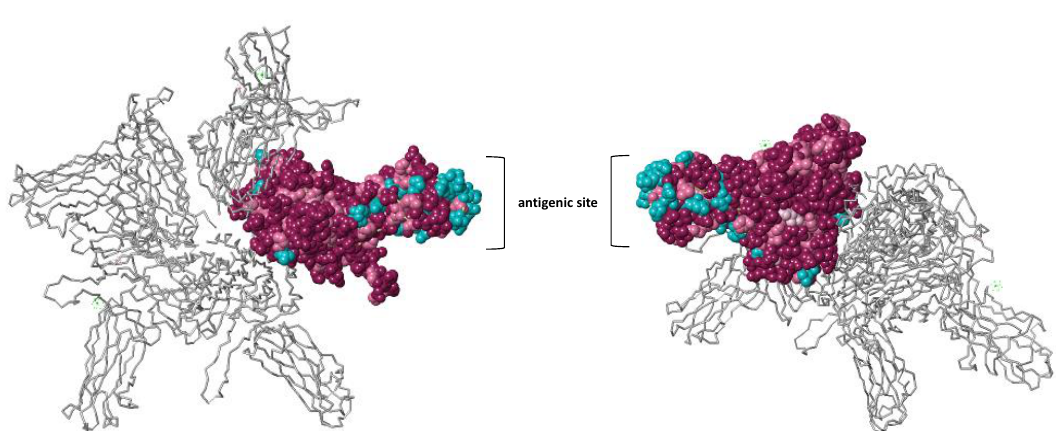
Figure 3. 3D structural analysis of the VP2 protein. The conservation of the amino acid residues was estimated using the ConSurf Server [33] and based on the multiple alignments of Sp and Ab serotypes along with the 3IDE_1 PDB 3D structure. The left and right view of the protein is represented. One VP2 monomer is colored on the 3D structure of VP2, which is composed of 4 monomers. Conserved amino acid residues are colored in purple. Pink residues, less conserved than purple residues, are colored in pink. The least conserved residues are colored in blue.